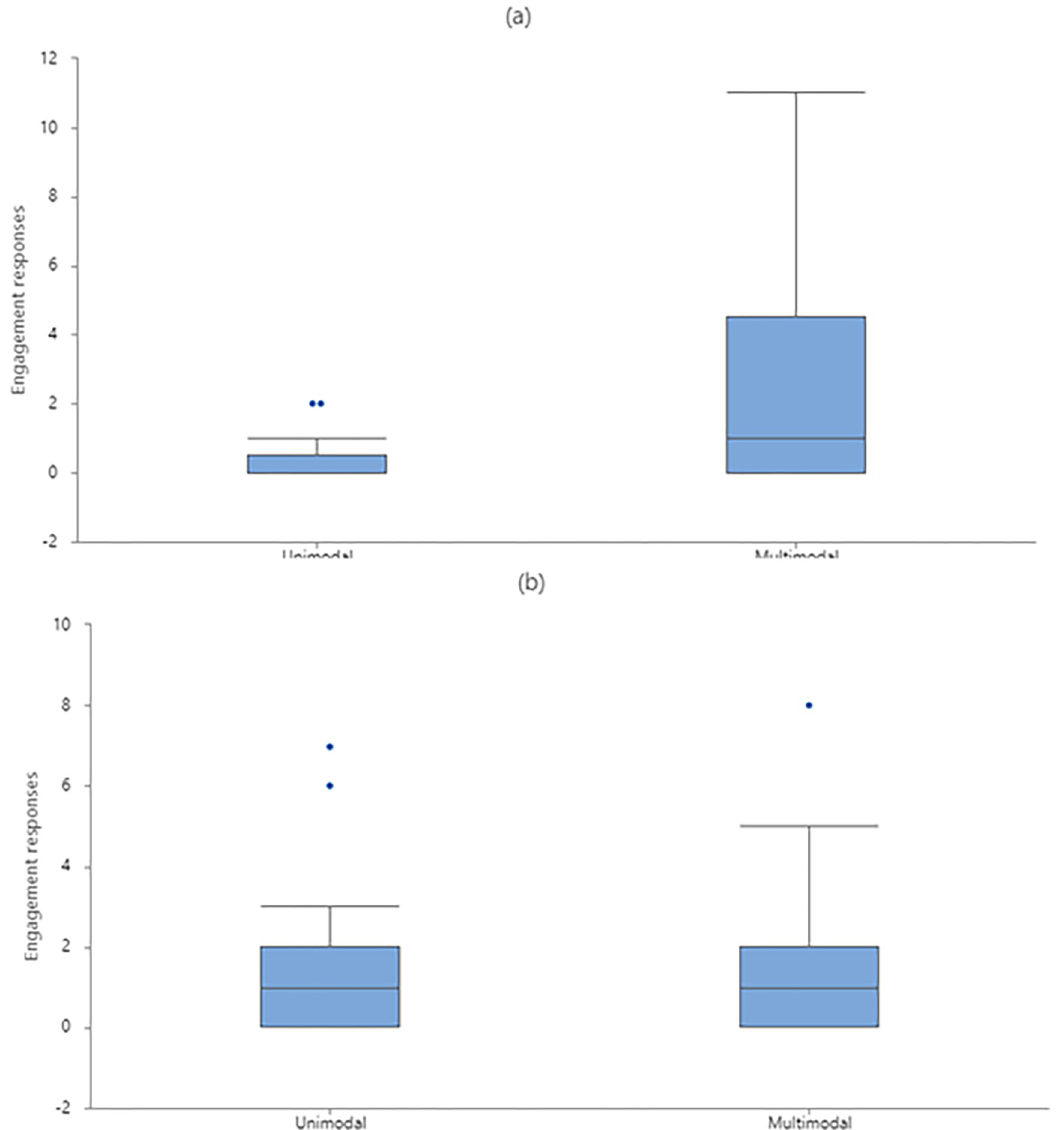
Fig 7. Occurrences of engagement responses to unimodal and multimodal signals produced by white-lipped peccaries (N = 21). (a) Animals were displaying threatening behaviors. (b) Animals were displaying submissive behaviors. Box-and-whisker diagram shows the smallest and largest observations (except outlier(s); box) and lower quartile, median, upper quartile (whiskers). Points represent outliers.